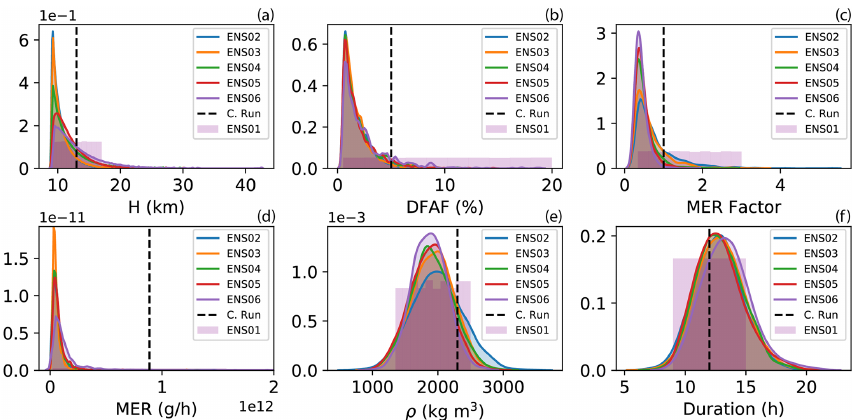
Figure 6. Evolution of ESPs distributions for ENS01 (purple shading), ENS02 (blue shading), ENS03 (orange shading), ENS04 (green shading), ENS05 (red shading), and ENS06 (dark purple shading). Each panel shows (a) plume height ( H ), (b) distal fine ash fraction (DFAF), (c) mass eruption rate factor (MERF), (d) mass eruption rate (MER), (e) ash density ( ρ ), and (f) eruption duration. For ENS01, each parameter is sampled from a uniform distribution. For ENS02–06, each parameter is sampled from posterior pdfs following a fit of the members WLoA and considering the interaction among the parameters. MER is plotted to show its evolution, although it is not explicitly perturbed in any of the ensembles. Dashed black lines in each plot represent the parameter value used for the control run. The evolution of ESPs distributions for ENS07–ENS11 are shown in Appendix B (Fig.